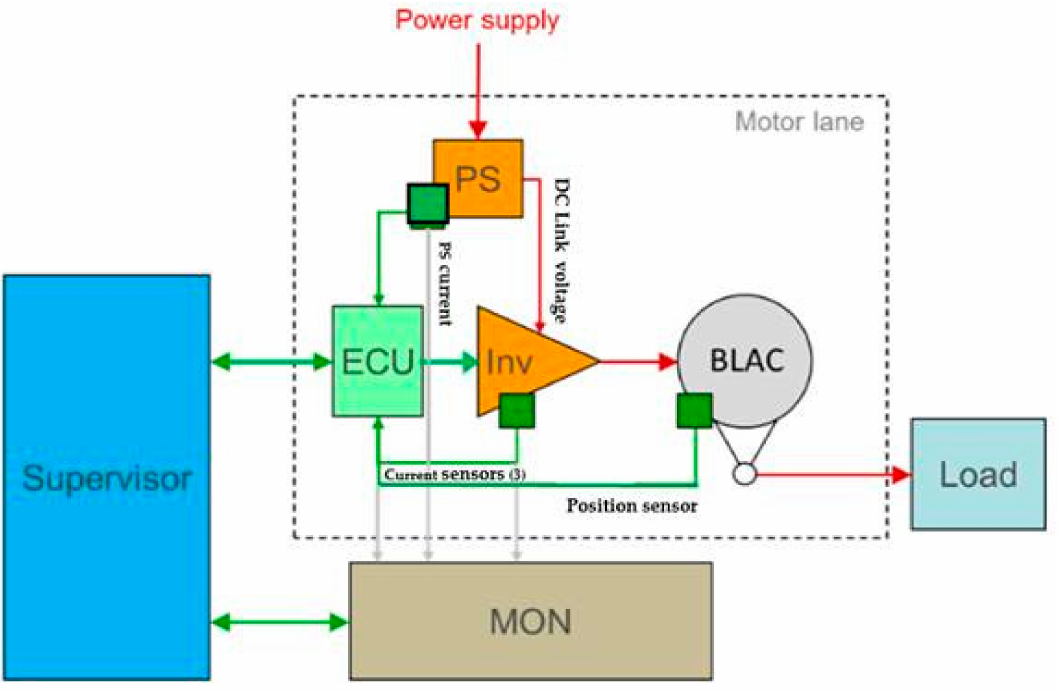
Figure 12. Control strategy of each BLAC